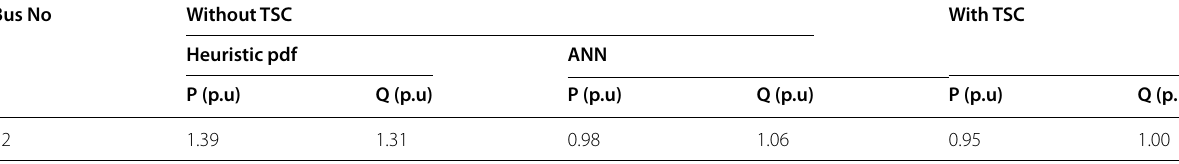
Table 22 Power flow comparison with and without TSC in IEEE 57- bus system at bus 12 Bus No Without TSC With TSC